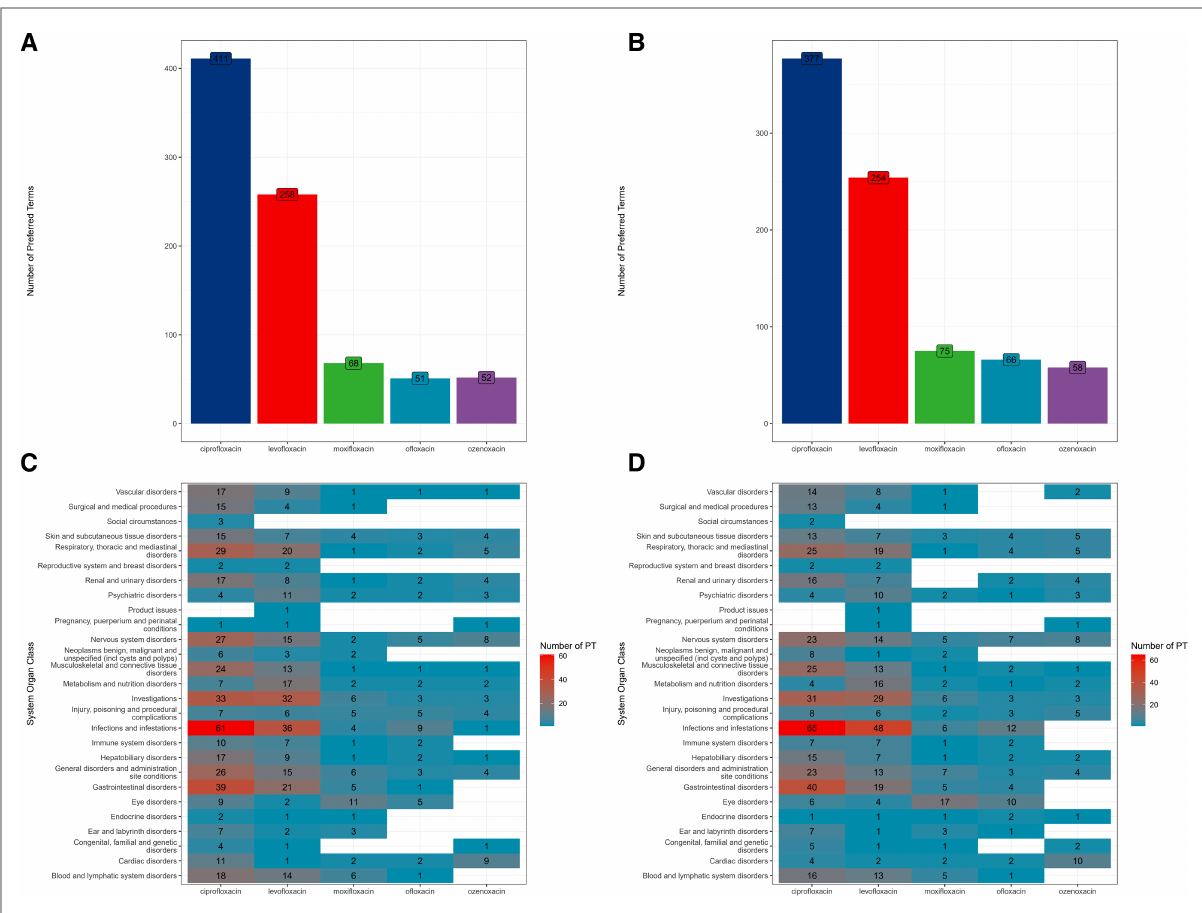
FIGURE 2 The number of signals of AE reports at SOC and PT levels using ROR and BCPNN algorithms. ( A ) signals of AE reports detected by ROR algorithm; ( B ) signals of AE reports detected by BCPNN algorithm; ( C ) signals of AE reports detected by ROR algorithm at SOC level; ( D ) signals of AE reports detected by BCPNN algorithm at SOC